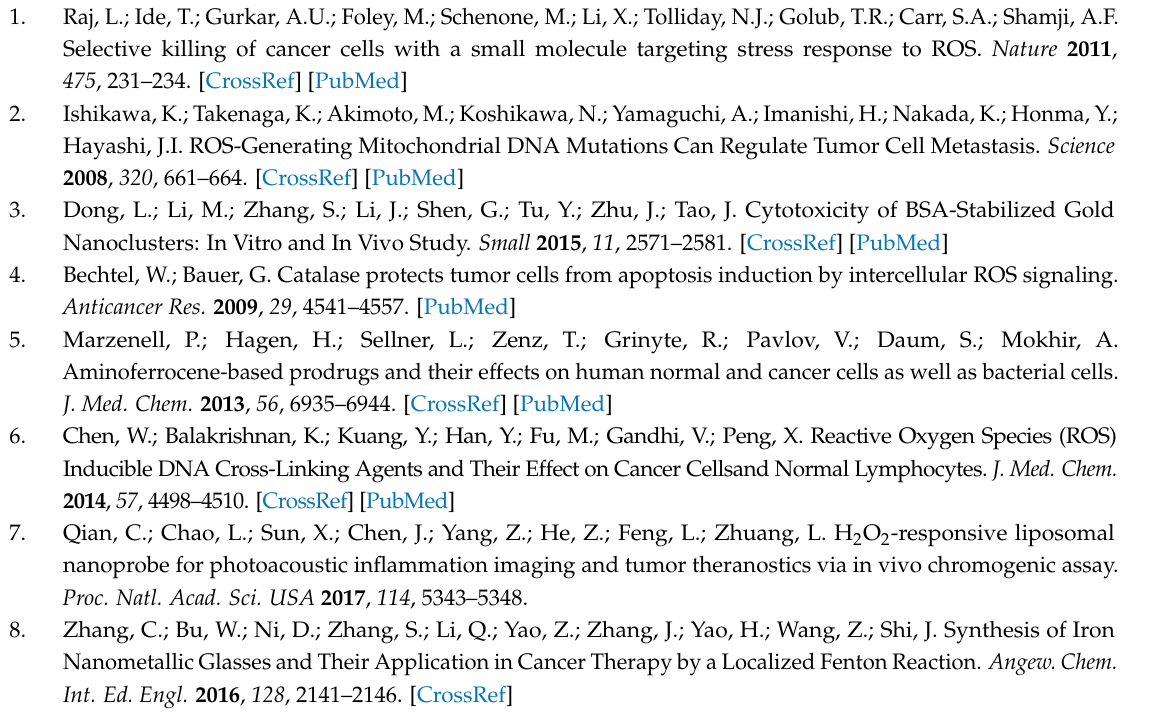
s1. Figure S1: Stability investigation of as-prepared AuCs in 60 days by tracing the fluorescence intensity. Figure S2: CLSM images of U87-MG and HeLa cells incubated with 40 µ M AuCs for 24 h. The excitation wavelength is 405 nm, and blank cells were used as control. Figure S3: Statistical results of relative fluorescence intensity indicating mitochondrial membrane potential change. The ratio of green and red fluorescence intensity of cells incubated with AuCs for 12 h was set to 100%. *** P <